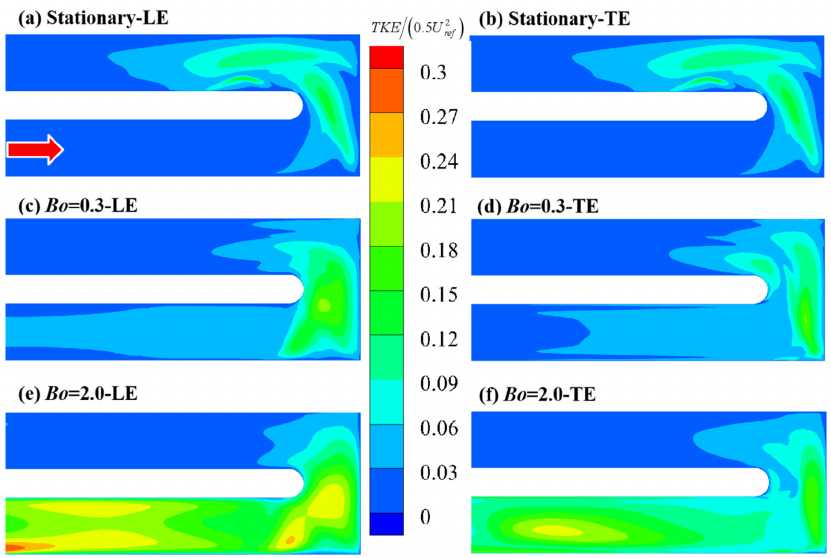
Figure 10. Non-dimensional TKE in meridian planes at Z / H = 0.9 (near LE) and 0.1 (near TE) of smooth channel.